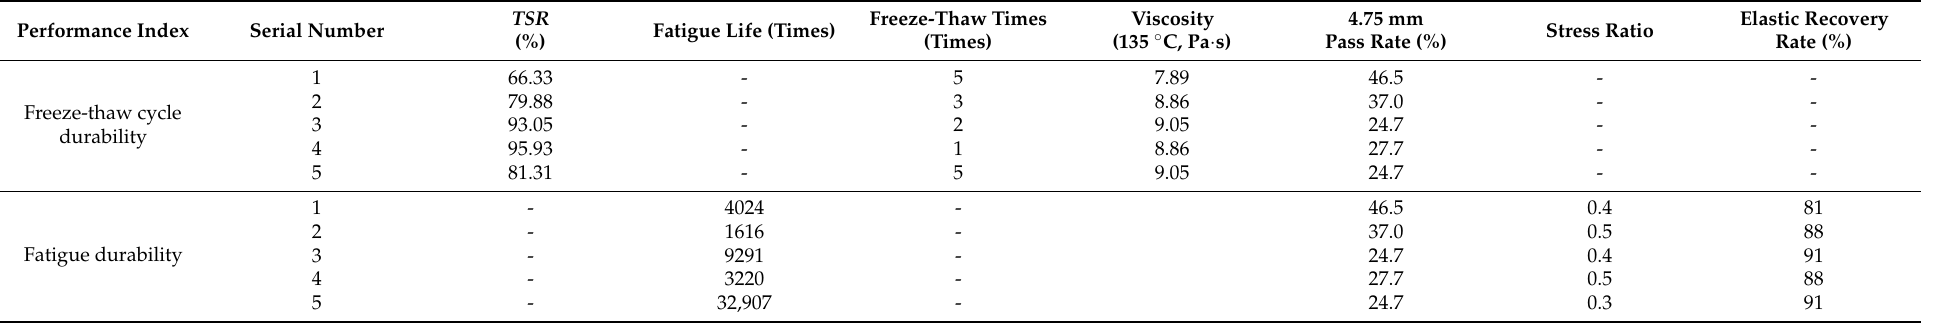
Table 10. Evaluation indexes and influence parameters of freeze-thaw cycle durability and fatigue durability of fiber asphalt